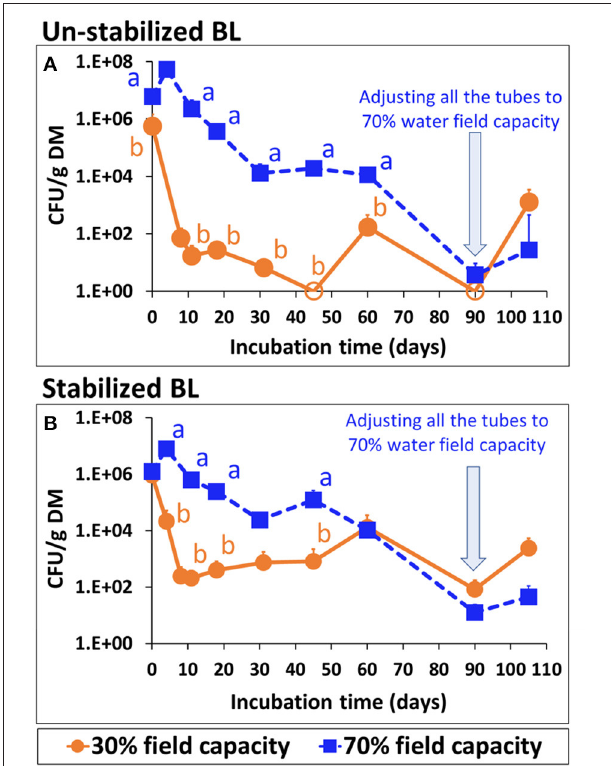
FIGURE 8 | Persistence of S . Infantis in a vertisol soil amended with 5% (v/v) of un-stabilized or stabilized broiler liter (BL), adjusted to 30 or 70% water field capacity. (A) Un-stabilized BL. (B) Stabilized BL. Letters denote significant differences between treatments at time intervals (log-transformed CFU values; Tukey-Kramer HSD; P ≤ 0.05). Error bars represent the standard deviations of triplicate tubes. Empty symbols indicate values below the detection limit after enrichment (1–2 CFU g − 1 DM). DM, dry